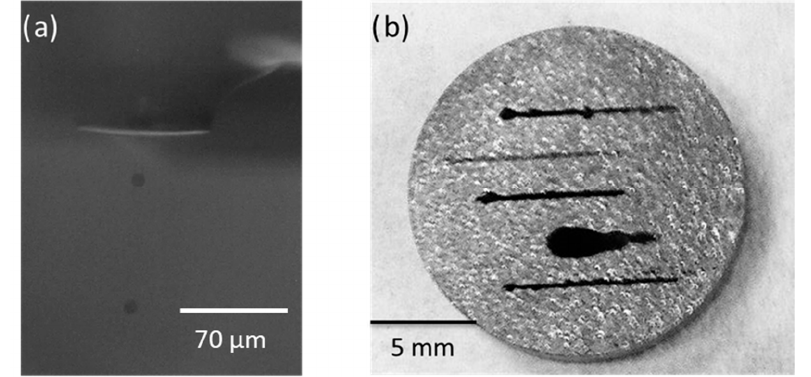
Figure 1. ( a ) Drop generation image and ( b ) TiN lines printed on Ti substrate under different conditions.